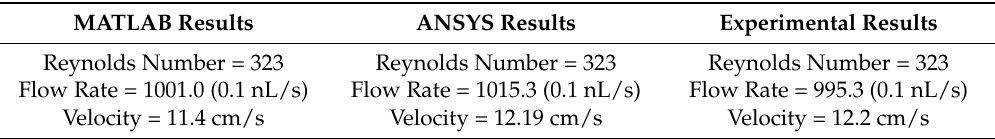
Table 3. The results of simulations and